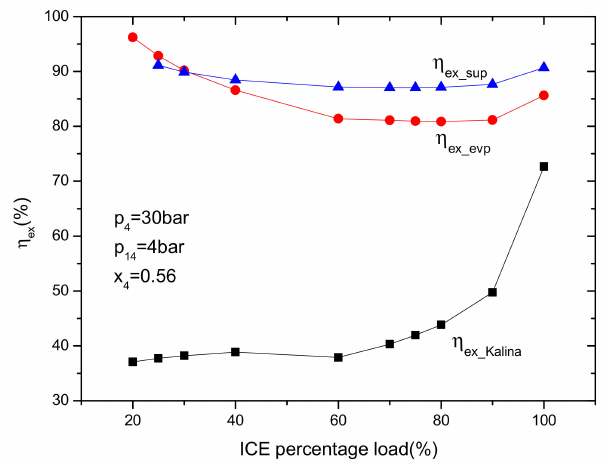
Figure 3. Effects of ICE percentage load on η ex_evp , η ex_sup and η ex_Kalina .